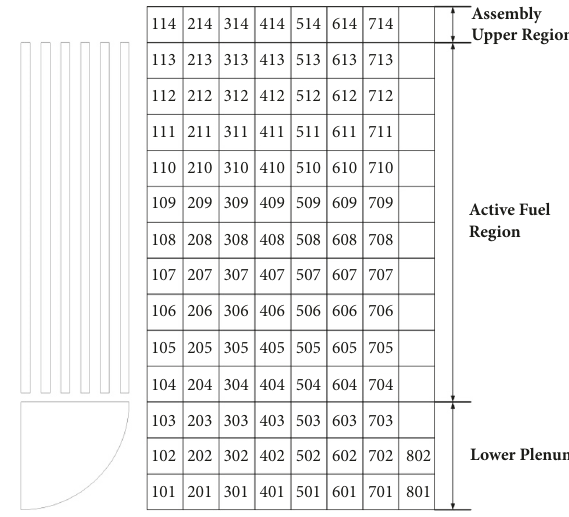
Figure 2: MELCOR nodalization for core.